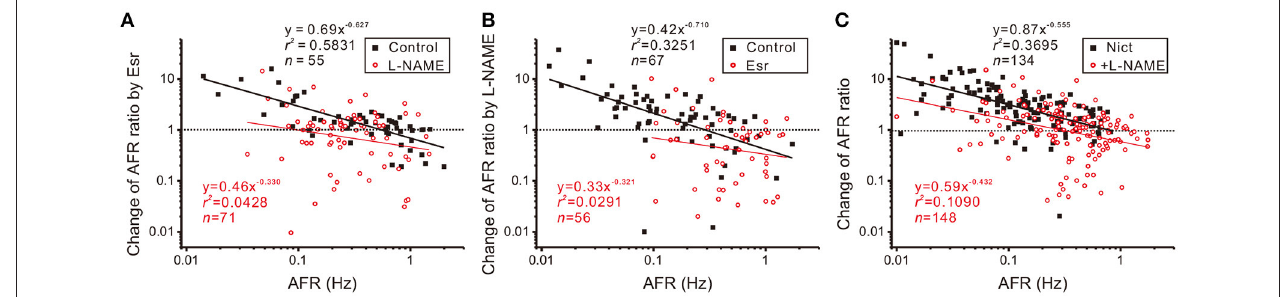
FIGURE 7 | Interplay of cholinergic neurotransmission and NO signaling via nicotinic receptor activation causes plFM. (A) Firing modulations induced by applications of 10 µ M eserine (Esr, an acetylcholinesterase inhibitor) with or without 100 µ M L-NAME pretreatments. Esr-induced plFM were diminished by L-NAME pretreatments. Significance of regression: P < 0.00001 under control and P = 0.0857 with L-NAME pretreatment. CI b : − 0.794 to − 0.459 under control and − 0.766 to 0.101 with L-NAME pretreatment. (B) Firing modulations induced by applications of 100 µ M L-NAME with or without 10 µ M Esr pretreatments. L-NAME-induced plFM were diminished by Esr pretreatments. Significance of regression: P < 0.00001 under control and P = 0.2131 with Esr pretreatments. CI b : − 1.002 to − 0.419 under control and − 0.902 to 0.260 with Esr pretreatment. (C) Firing modulations induced by applications of 1 µ M nicotine (Nict, a nicotinic receptor agonist) followed by addition of 100 µ M L-NAME. The plFM were induced by Nict and persisted after addition of L-NAME. Significance of regression: P < 0.00001 by Nict and P < 0.00005 by addition of L-NAME. CI b : − 0.698 to − 0.412 by Nict and − 0.664 to − 0.201 by addition of L-NAME.